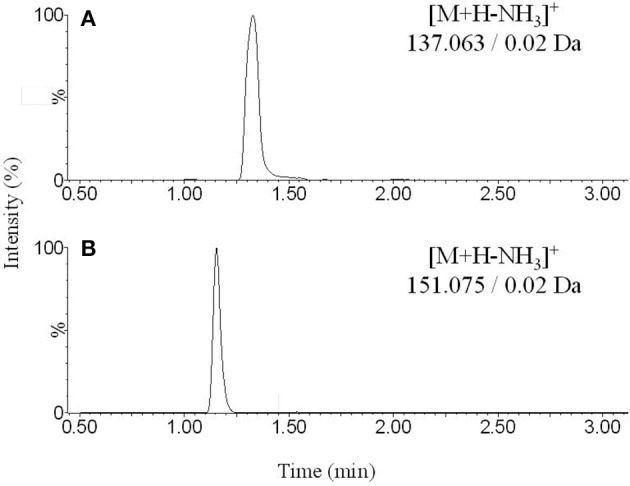
Representative chromatograms obtained from extracted blank sample spiked with (A) dopamine and (B) 3-methoxytyramine.